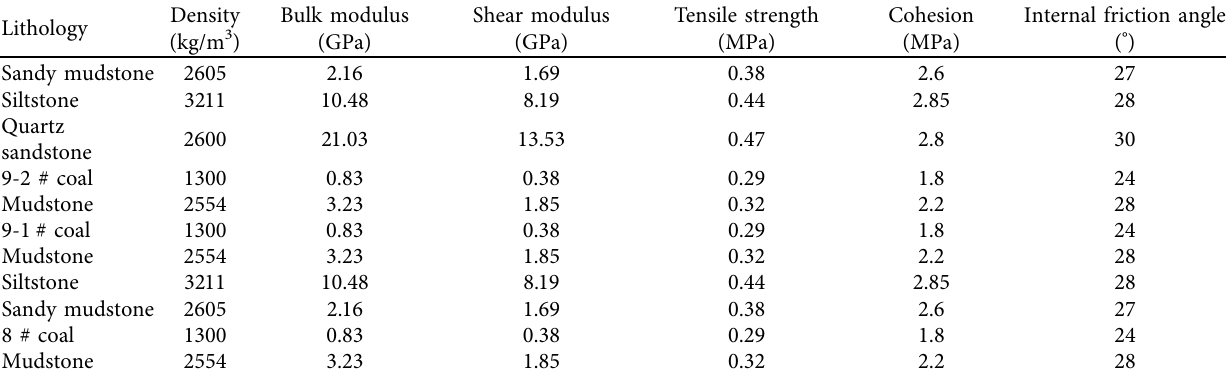
Table 1: Mechanical parameters of the roof and floor rock strata at the coal